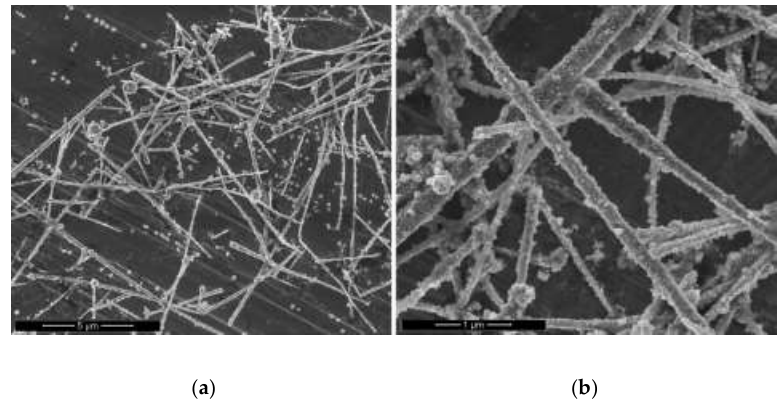
Figure 17. SEM images of Cu-Ag nanowires: (a) scale bar 5 µm; (b) 1 µm.